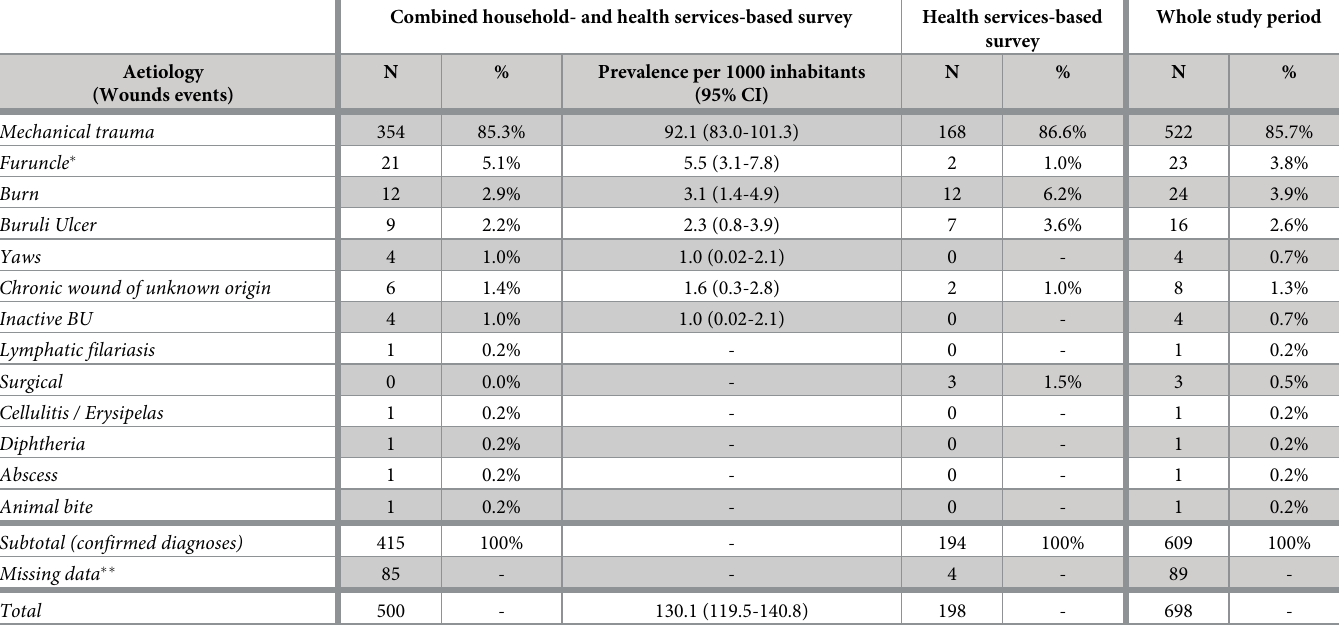
Table 4. Estimated wound prevalence and aetiology distribution stratified by study